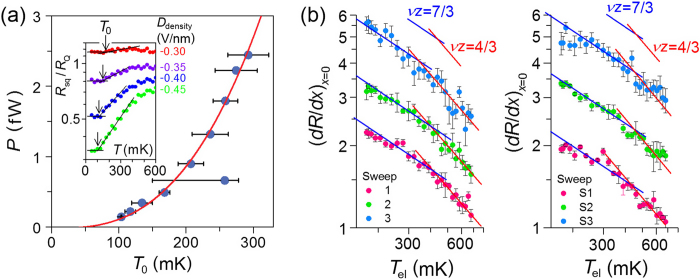
Estimation of electron temperature and temperature dependence of critical exponent products.(a) Relationship between the heating-induced crossover temperature T0 and the dissipative Joule-heating power P. The solid curve is a fit to Rsq data close to the transition in a logarithmic scale. The horizontal lines are guides for the levelling-off of Rsq and the arrows indicate T0. (b) Electron temperature (Tel)-dependence of resistance slope (dR/dx)x=0. For clarity, each data set was shifted vertically by an arbitrary offset. The red and blue linear curves indicate the slope expected with classical and quantum percolation, respectively.